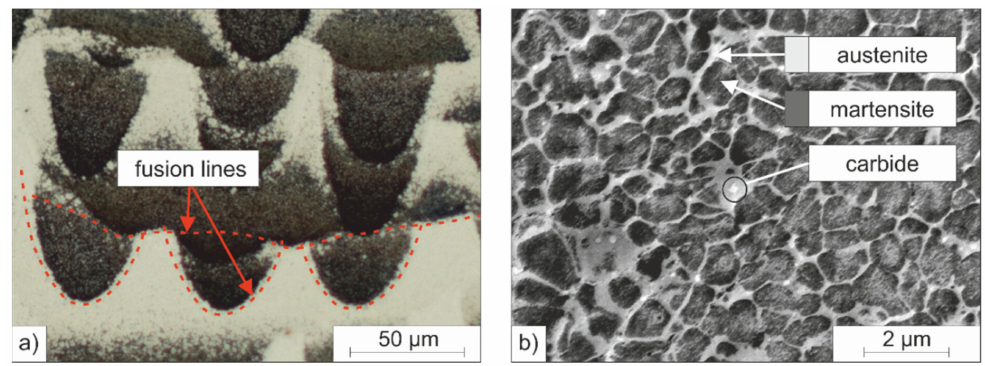
Figure 12. ( a ) Layer-like microstructure of the PBF-LB/M-fabricated samples at lower magnification; ( b ) cellular microstructure of the individual cells formed at a higher magnification, consisting of bcc nuclei surrounded by fcc